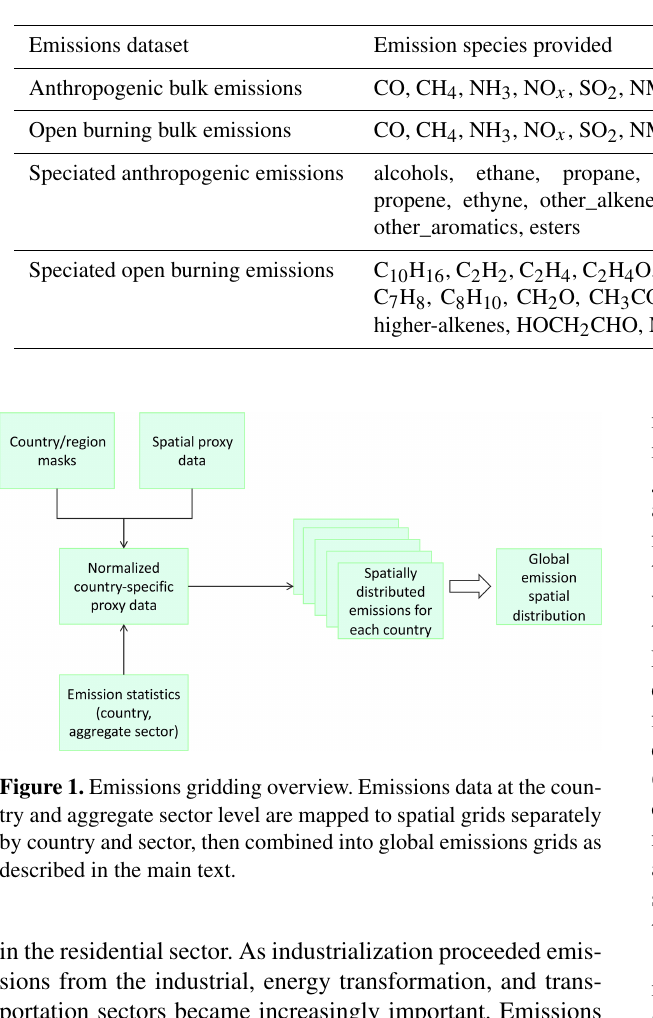
Table 1. Emission species provided in the emission data files. For the molecular weights assumed for each species, see https://GitHub.com/ iiasa/emissions_downscaling/wiki (last access: 1 August 2019).